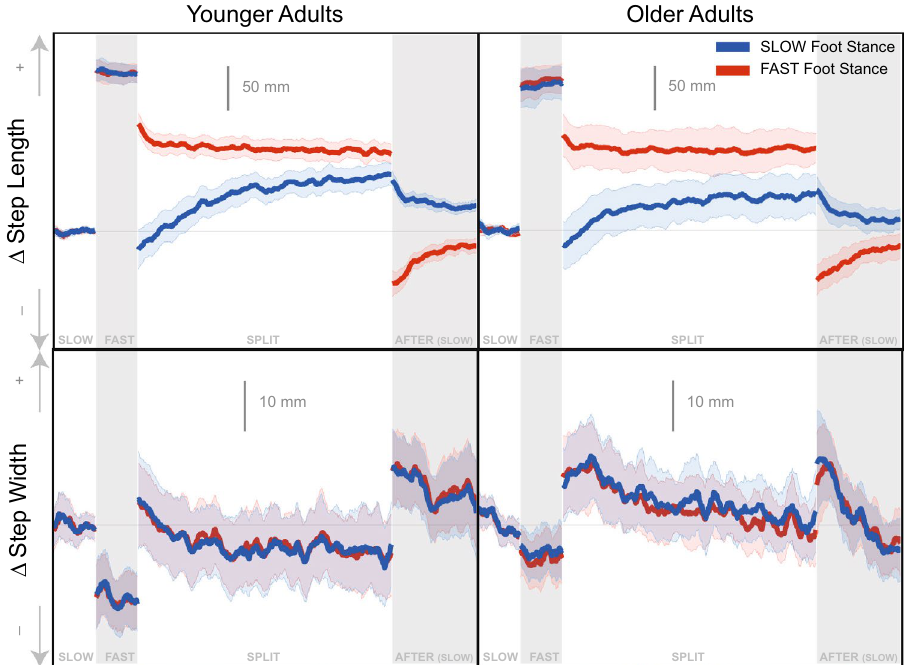
Figure 1. Spatial Gait Parameters adaptation time series graphs for younger (left column) and older (right column) adults. The time-series data were smoothed with a 2 step sliding window moving average for display purposes. The blue data corresponds to the right foot, and the foot that made contact with the slow belt during split condition. The red data corresponds to the left foot, and the foot that made contact with the fast belt during split condition. The bolded lines indicate the group mean. The shaded areas represent the 95% confidence interval of the group mean. All values are represented as a change from the average of the slow condition ( (cid:31) ). + indicates more forward for step length and wider for step